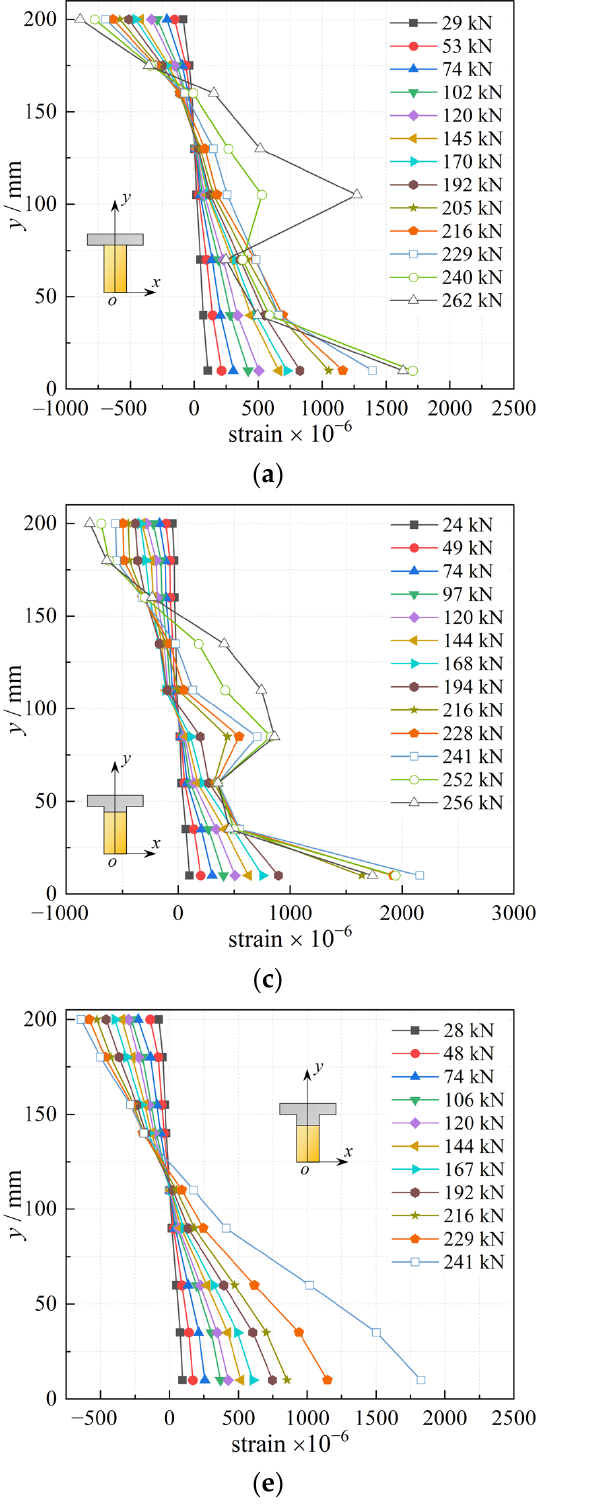
Figure 11. The result of the vertical distribution of the longitudinal strain; ( a ) B1-1; ( b ) B1-2; ( c ) B2-1; ( d ) B2-2; ( e ) B3-1; ( f ) B3-2.